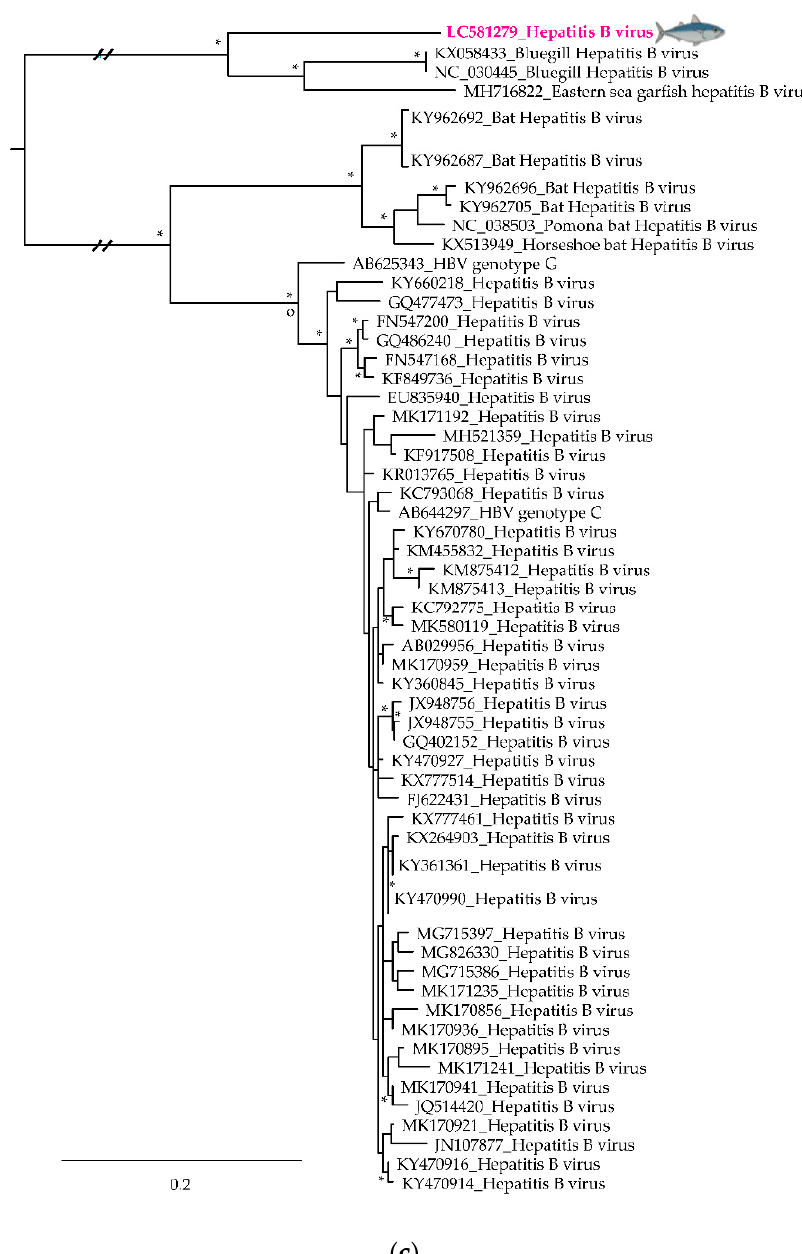
Figure 4. Phylogenetics trees of common fish pathogenic viruses: ( a ) Nodaviridae —partial sequence of Viral Nervous Necrosis Virus amplified from gilthead seabream gills from Algarve, ( b ) Birnaviridae —partial sequence of Infectious Pancreatic Necrotic Virus detected in Atlantic horse mackerel skin from Peniche, ( c ) Hepadnaviridae —partial sequence of Hepatitis B virus obtained from Atlantic horse mackerel gills from Algarve. The viral sequences analyzed in this study are colored and highlighted by a fish. All viral sequences are identified by their accession number and name. At specific branch nodes, bootstrap branches ≥ 0.60 are displayed by *; branch node point out with a circle referred to human viral sequences.